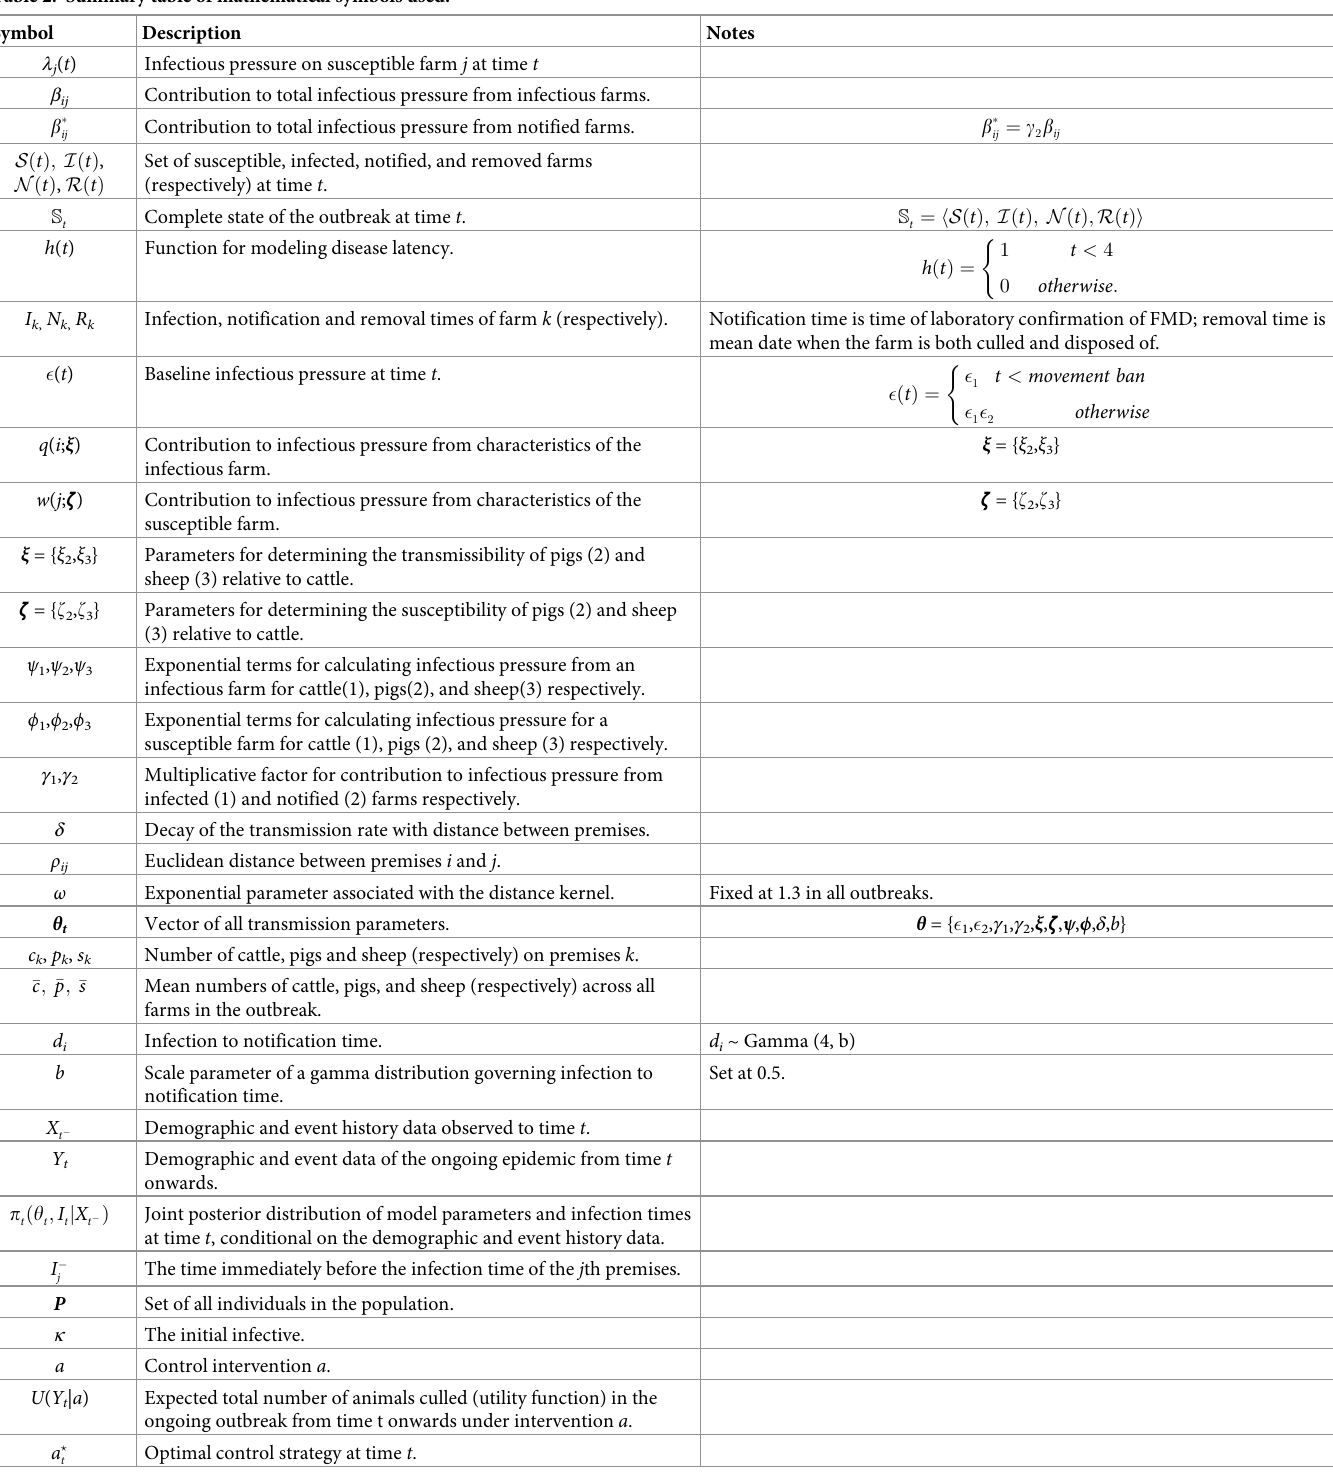
Table 2. Summary table of mathematical symbols used.